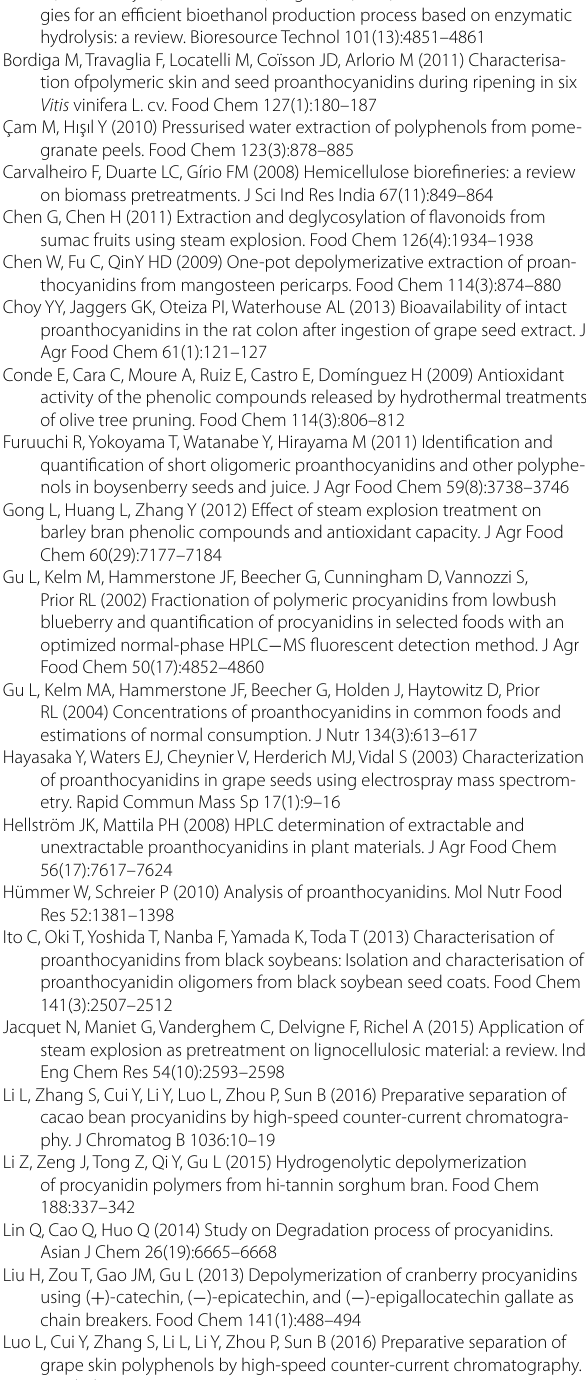
Table S2 . The identification and peak assignment of procyanidins units after